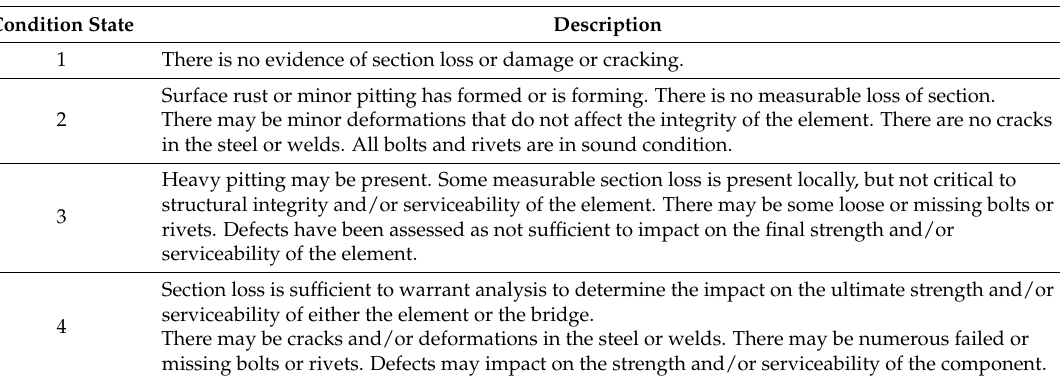
Table 1. Road and Traffic Authority (RTA) condition rating system